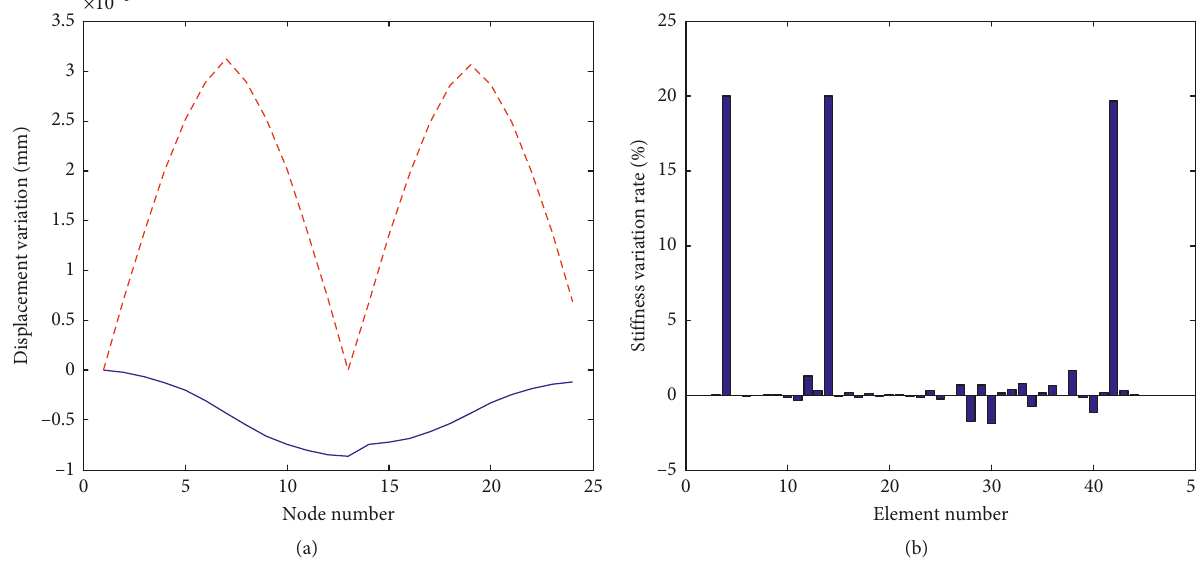
Figure 8: Numerical results using the complete measurement data contaminated by 1% noise level: (a) displacement variations; (b) stiffness variation rate. In (a), the solid line indicates the horizontal displacement and the dashed line indicates the vertical